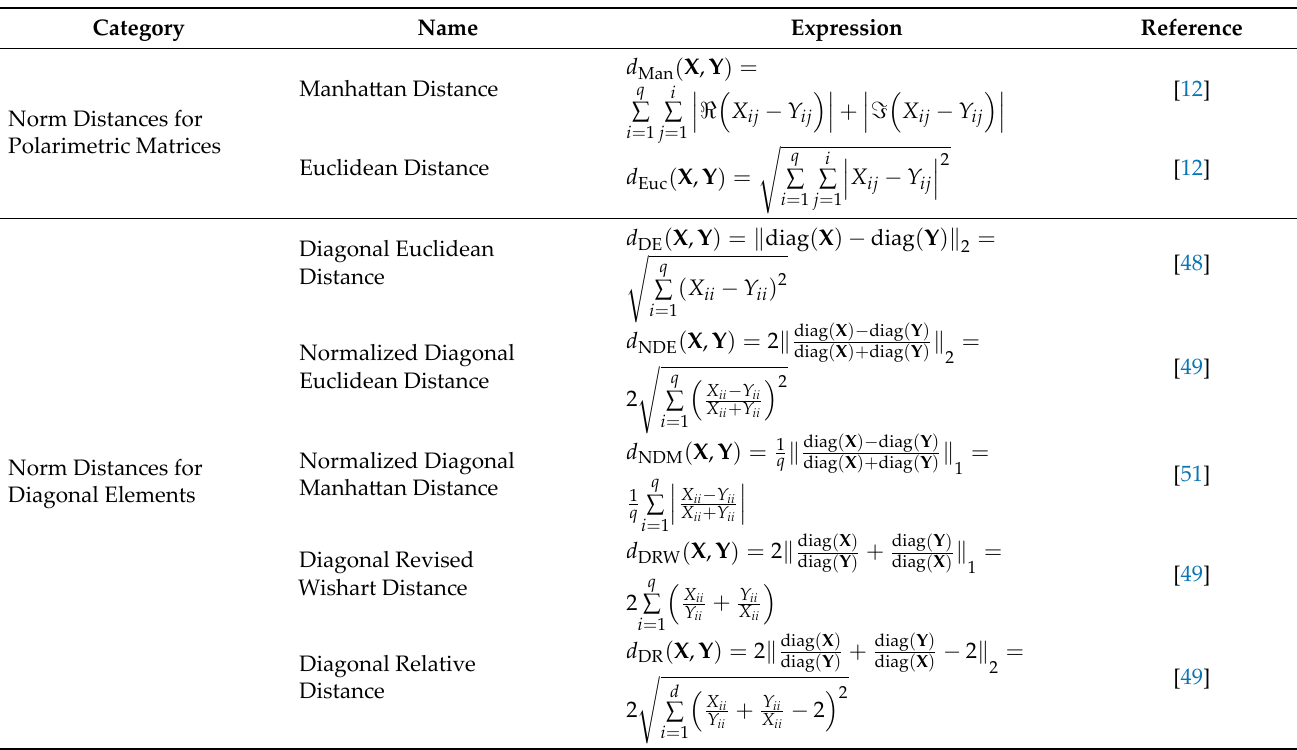
Table 2 lists the main inter‑pixel norm distances for PolSAR image data. Table 2. Inter‑pixel norm distances for PolSAR image